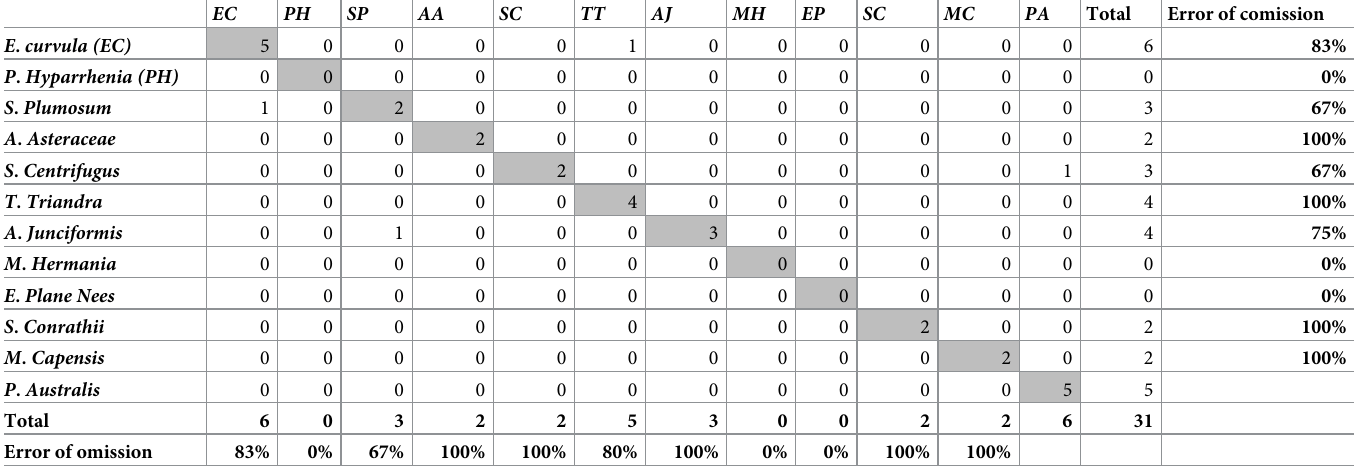
Table 2. Confusion matrix for Sentinel-2